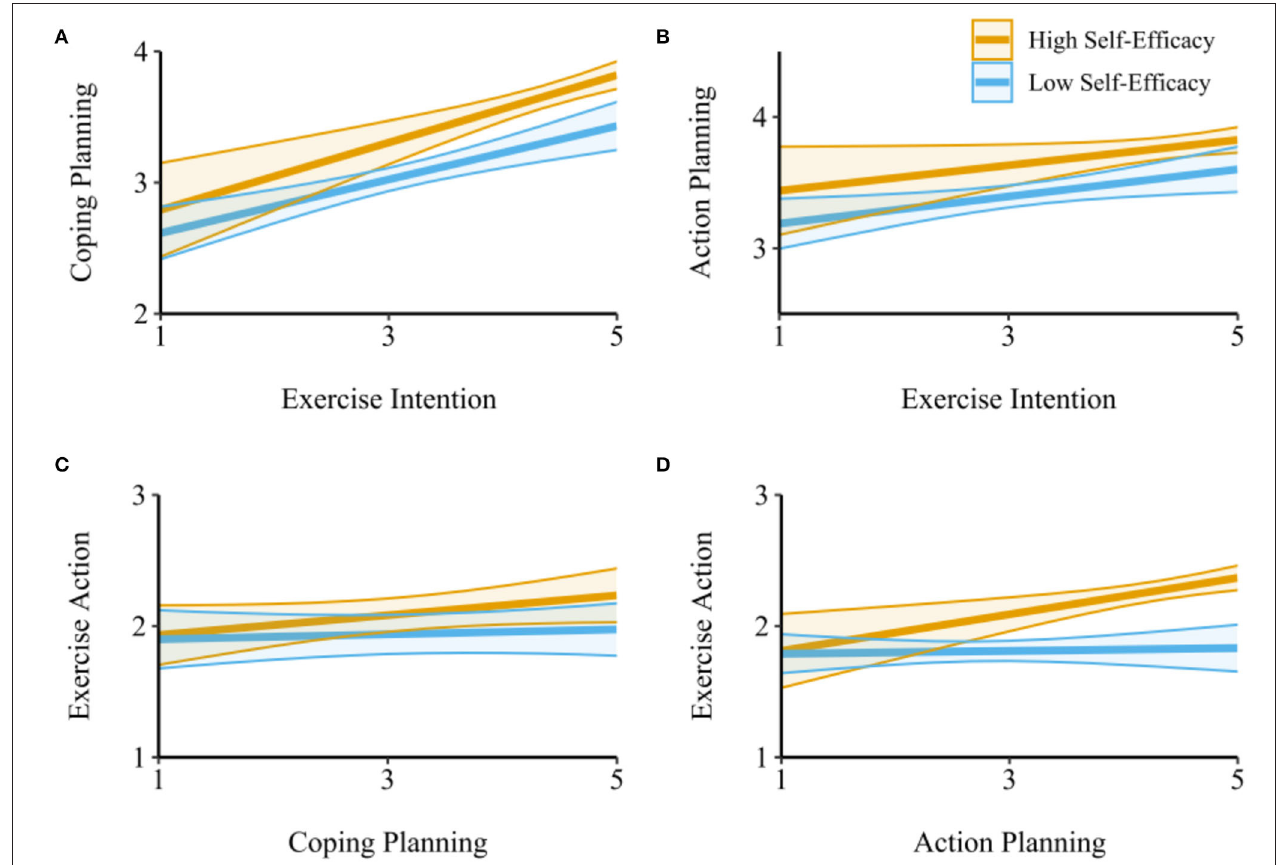
FIGURE 3 | The results of simple slope analysis. The moderating effect of self-efficacy on the relationship between exercise intention and coping planning (A) , between exercise intention and action planning (B) , between coping planning and exercise action (C) , and between action planning and exercise action (D)